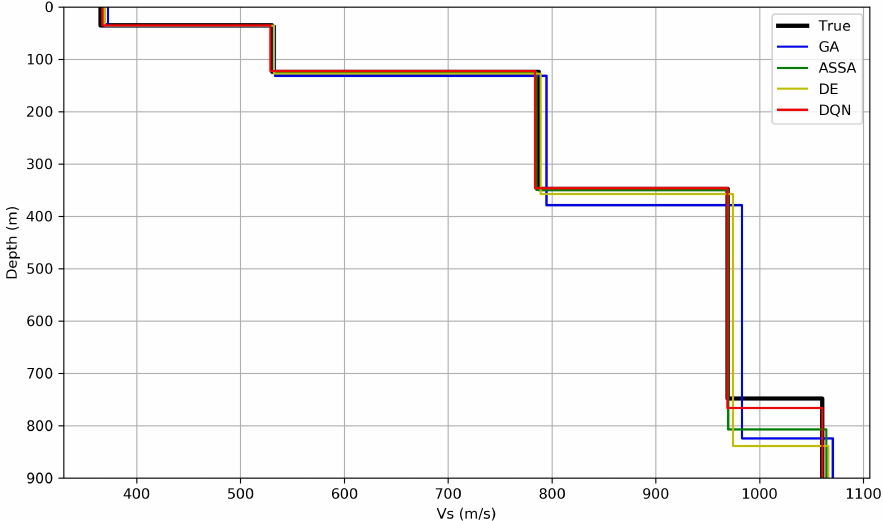
Figure 4. The estimated shear wave velocity profiles with the ground truth in Case 1.